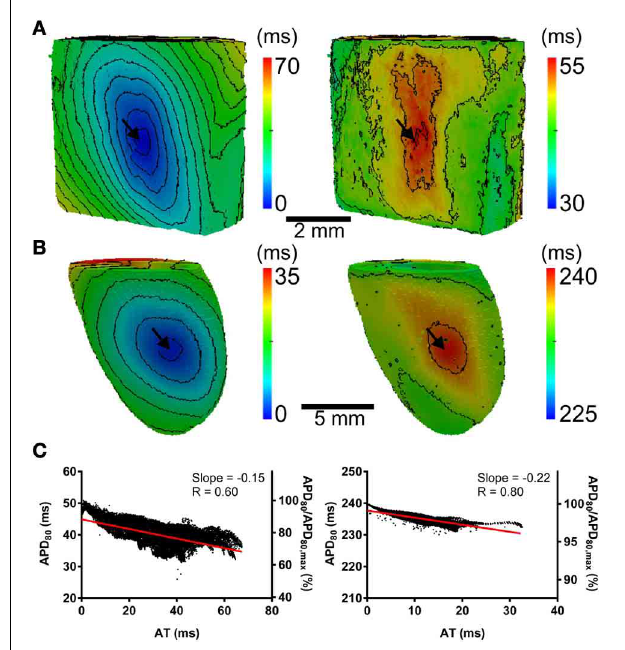
FIGURE 7 | The influence of electrophysiological kinetics and tissue geometry on the dispersion of APD. Electrophysiological kinetics for rat (R k ) and pig (P k ) simulations was interchanged between geometries (R g and P g , respectively). Ventricles were paced at the mid LV free wall (arrows). Panels are maps of AT (left panels) and APD 80 (right panels) derived from simulations in the following configurations: R k P g (A) P k R g (B) . Isochrones are 4ms for all maps. (C) AT-APD plots for R k P g (left panel) and P k R g (right panel) simulations. Slopes of linear correlation analyses are indicated. Secondary y -axes show APD 80 expressed as a percentage of maximum APD 80